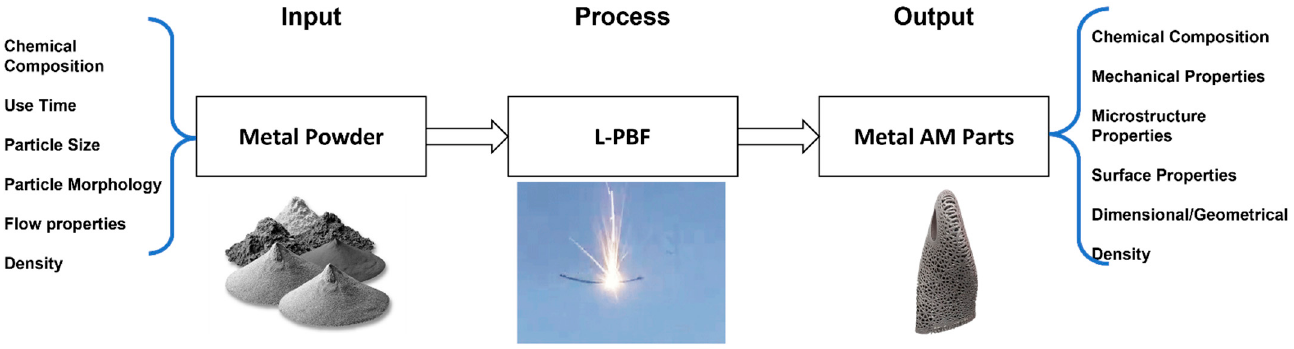
Figure 2. Input-Process-Output diagram for the LPBF process.